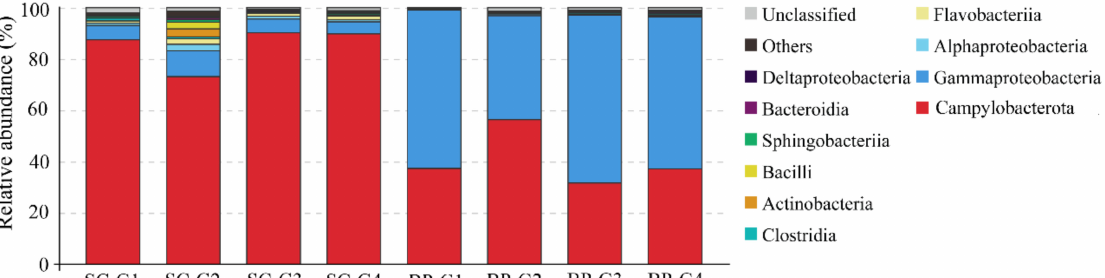
Figure 7. Diversity and distribution of microbial sequence tags in animal-associated libraries. SC-G1 SC-G2, SC-G3, and SC-G4 represent the libraries of the gills of Shinkaia crosnieri ; BP-G1, BP-G2, BP-G3, BP-G4 represent the libraries of the gills of Bathymodiolus platifrons . The sequence tags were generated with the next-generation sequencing platform and classified at the phylum / class level. Each color represents the percentage of the taxon in the total assemblage. The top 10 groups in each sample are labeled, and other groups are integrated as